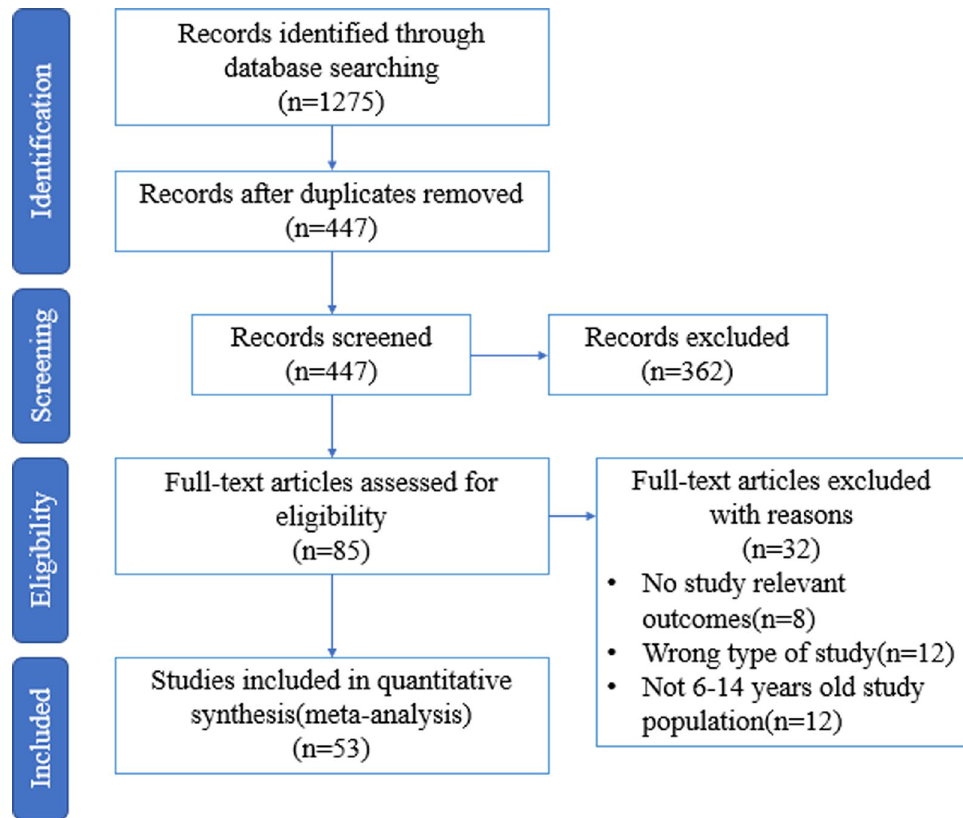
Fig. 1 Flow chart of literature